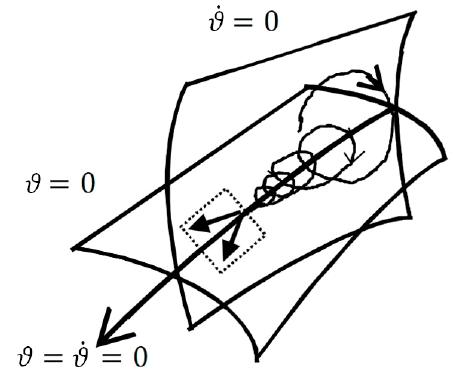
Figure 4. Convergence paths of the proposed controller.